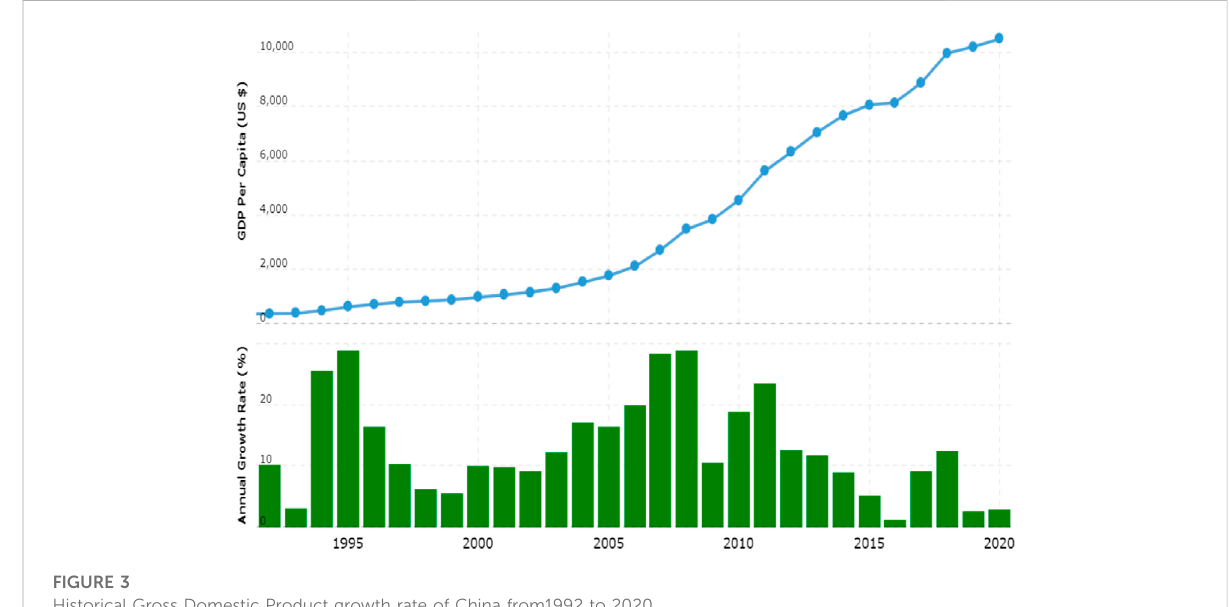
FIGURE 3 Historical Gross Domestic Product growth rate of China from1992 to 2020.